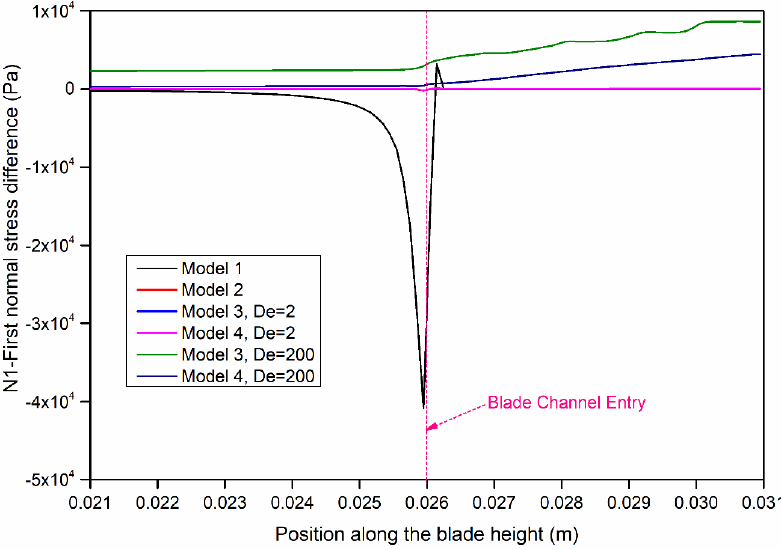
Figure 12. First normal stress difference distribution along the blade height.